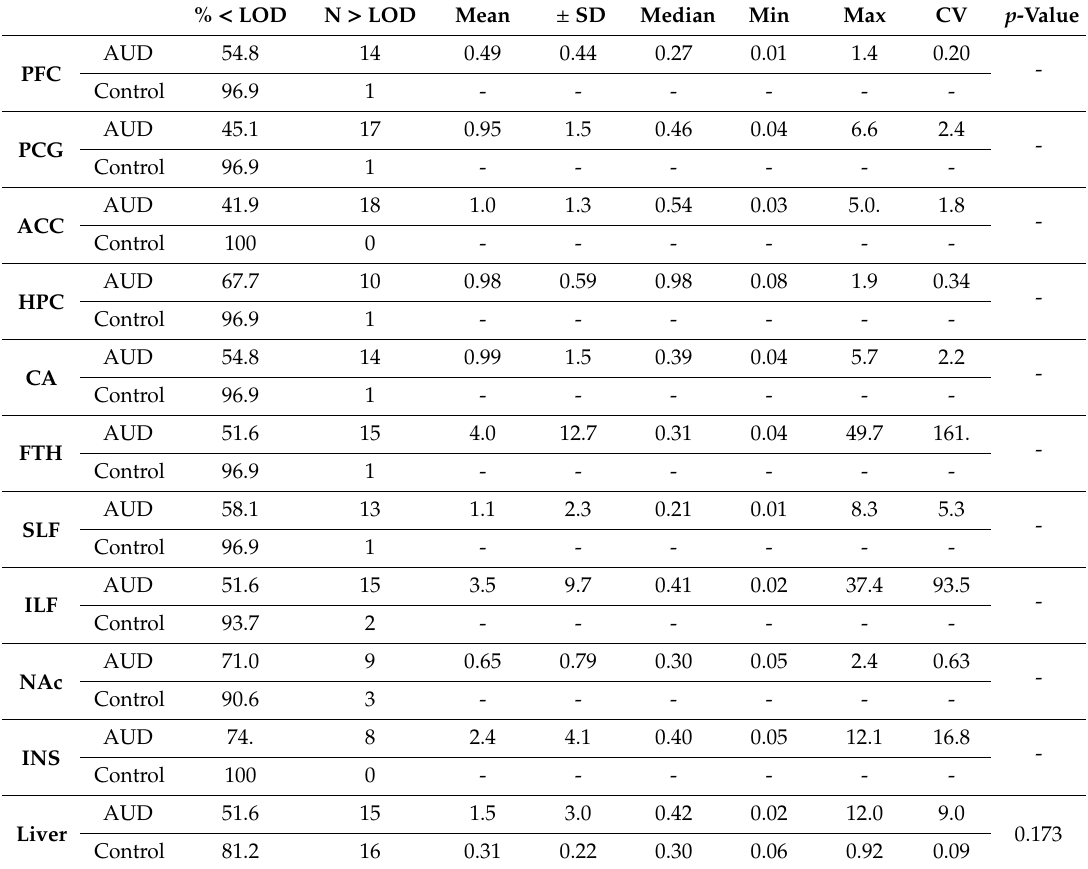
Table 2. Content of Al in alcohol use disorder (AUD) ( n = 31) and control ( n = 32) subjects in di ff erent brain structures and in the liver (mg /